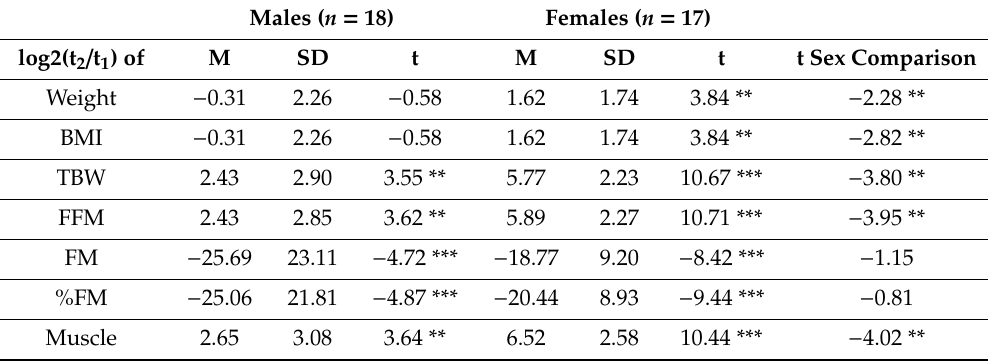
Table 3. Transformed values (M, SD) changes in body mass, body mass index (BMI), and estimates of body composition after the five week training program among male and female handball players and results of the t-tests. The transformed values are compared relative to "0". Results for the comparison of transformed values of males and females are also indicated along with results of t tests for independent